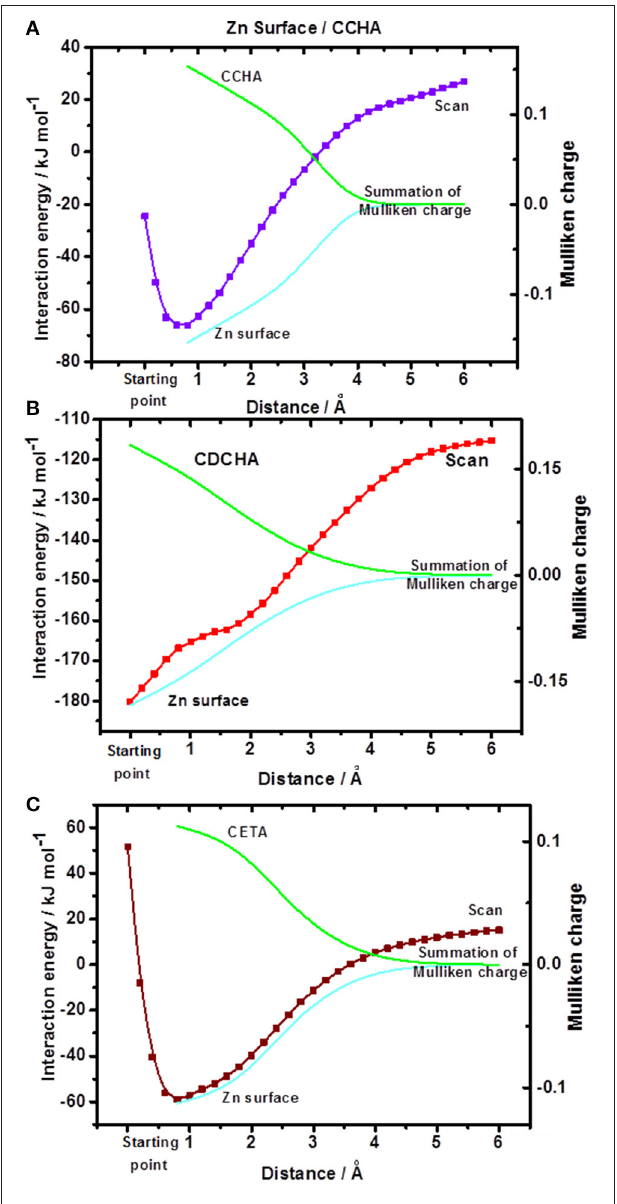
FIGURE 5 | Potential energy surfaces and Mulliken charges: (A) CCHA-Zn surface; (B) CDCHA-Zn surface; (C) CETA-Zn surface. The starting point corresponds to the distance in the optimized